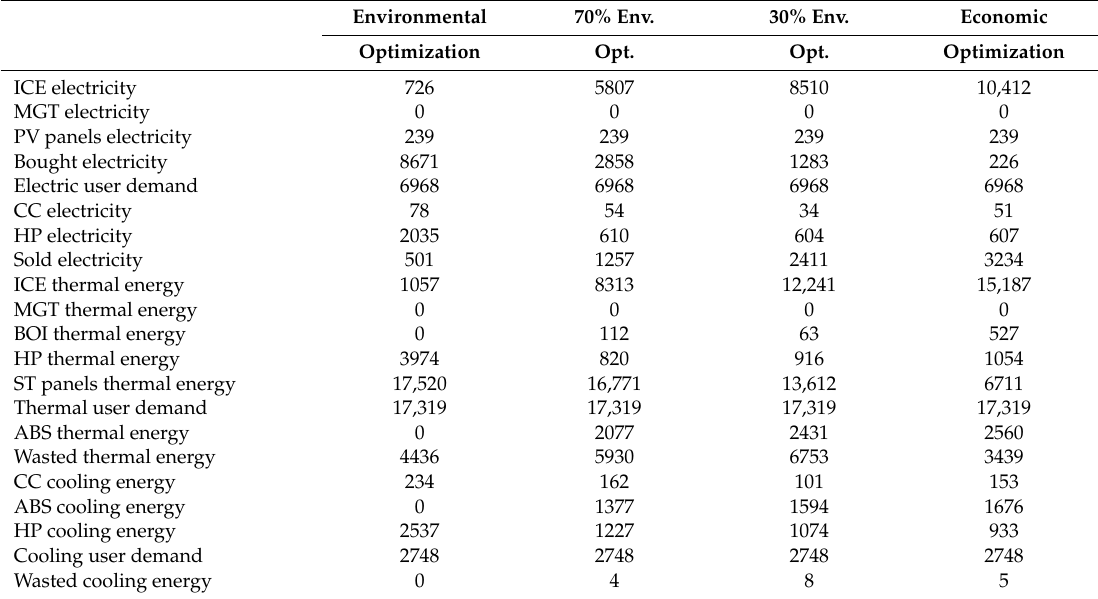
Table 17. Total optimal annual energy magnitudes (MWh)—complete distributed generation solutions.